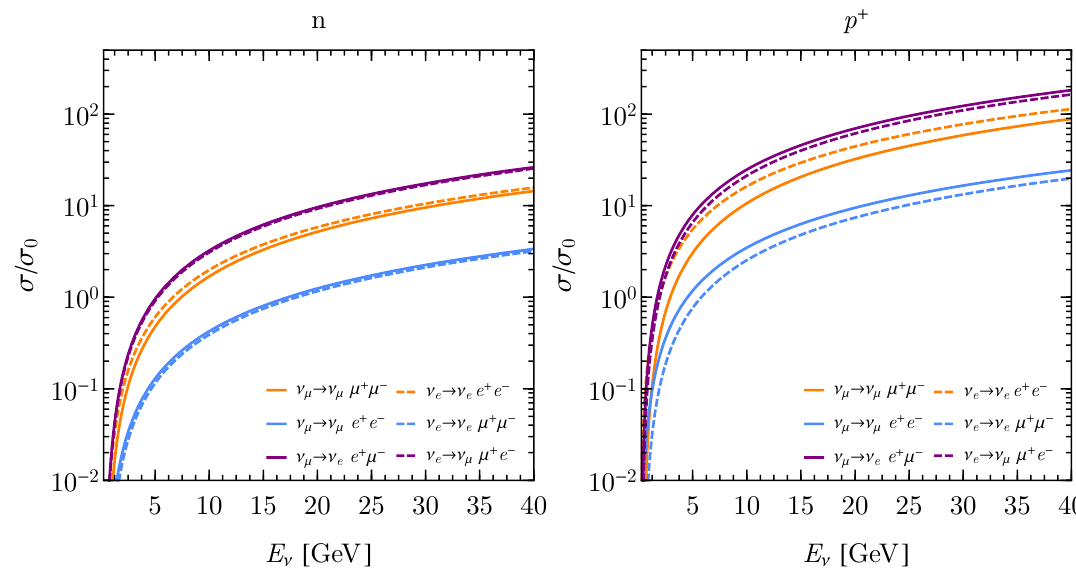
Figure 3 . Cross sections for di(cid:11)ractive neutrino trident production on neutrons (left) and protons (right), including Pauli blocking e(cid:11)ects as described in the text, normalized to (cid:27) 0 = 10 (cid:0) 44 cm 2 . The full (dashed) lines correspond to the scattering of an incoming (cid:23) (cid:22) ( (cid:23) e ) produced by the NC (light-blue), CC (purple), and CC+NC (orange) SM